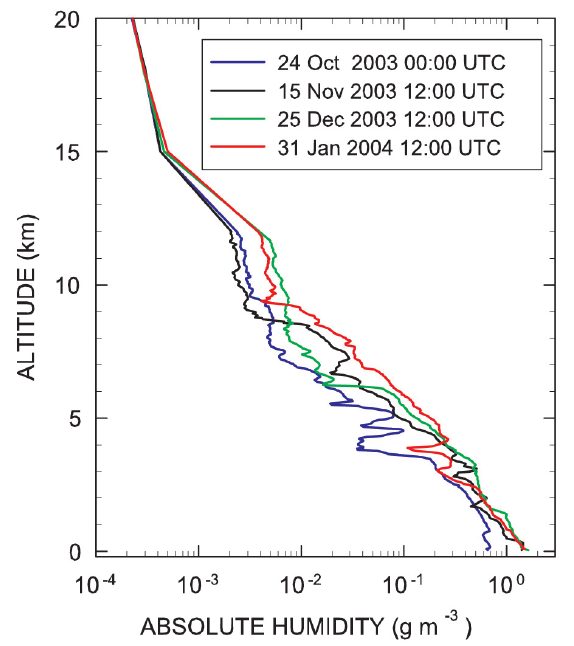
Figure 8. Four examples of vertical profiles of absolute humidity q ( z ) (measured in g m -3 ), as obtained from the radiosounding meas- urements performed at MZS (up to 12 km altitude) on four days of the 2003/2004 Austral summer, and completed with the monthly mean vertical profiles of q ( z ) defined by Tomasi et al. [2011a] ex- amining the MIPAS-ENVISAT observations recorded at levels z ≥ 15 km for the 75 °S latitude, while the vertical profile of q ( z ) over the 12 < z ≤ 15 km range was determined through a linear inter- polation in altitude between the natural logarithms of q ( z